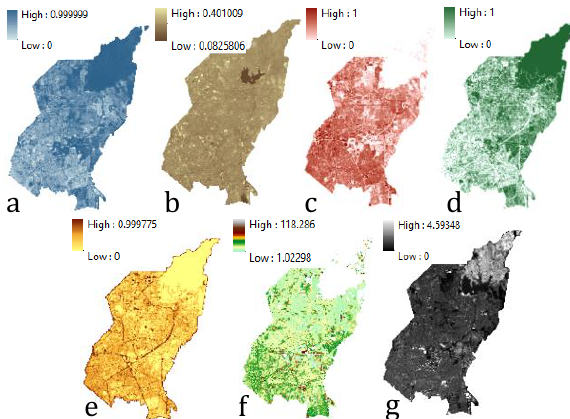
Figure 4. Derived layers of Local Climate Zones properties: (a) Sky View Factor (SVF), (b) Surface Albedo (SA), (c) Building Surface Fraction (BSF), (d) Pervious Surface Fraction (PSF), (e) Impervious Surface Fraction (ISF), (f) Building Height (BH), and (g) Roughness Length (Z 0